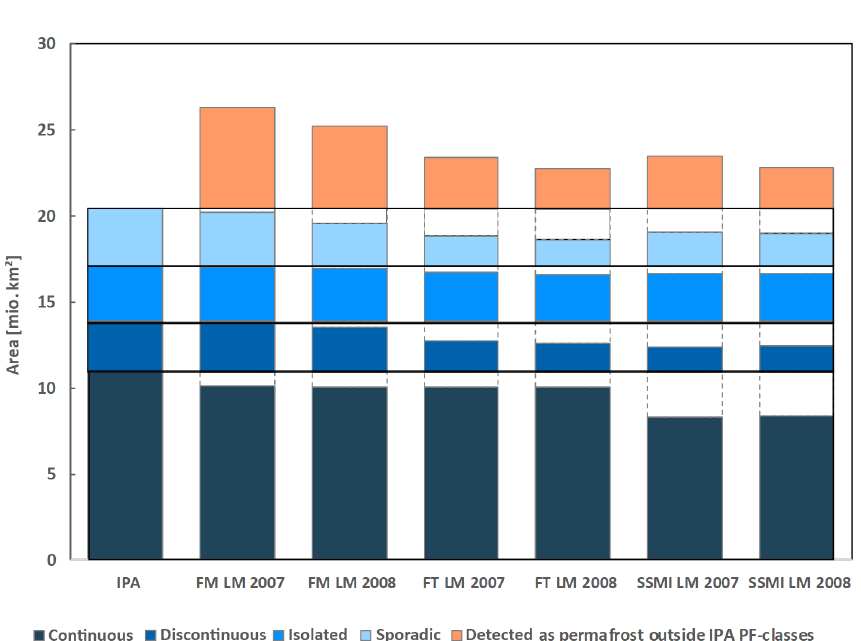
Figure 14. Permafrost extent comparison of satellite data results based on modelled ground temperatures (LM – linear model) with permafrost classes from Brown et al. (1997). Covered area in square kilometres within and outside each class. FT – days identified as frozen with ASCAT; FM – days with melting snow are considered to be frozen ground with